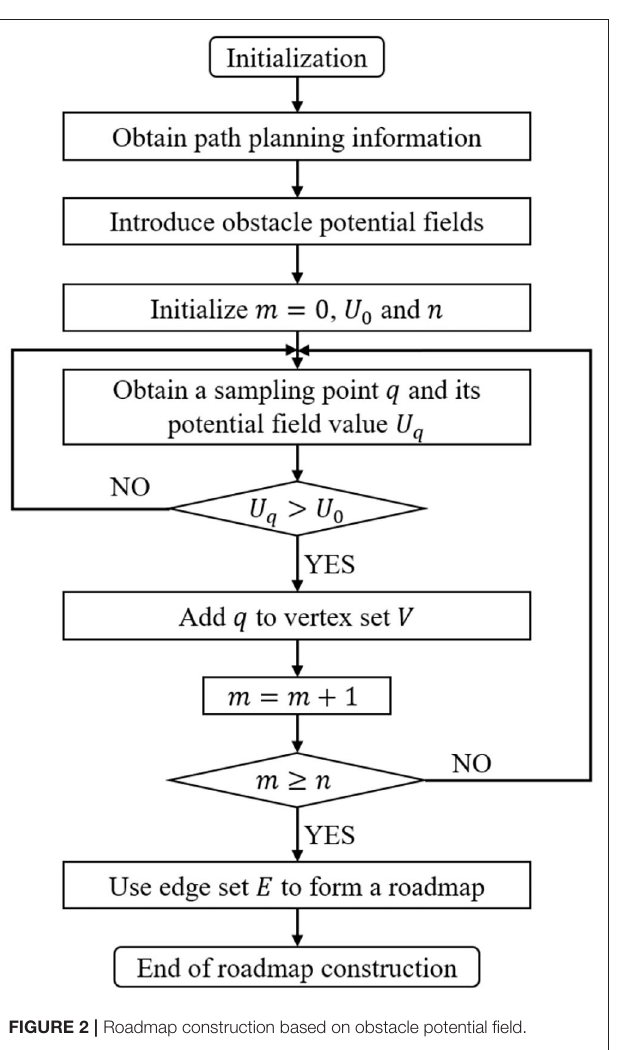
Frontiers in Neurorobotics |